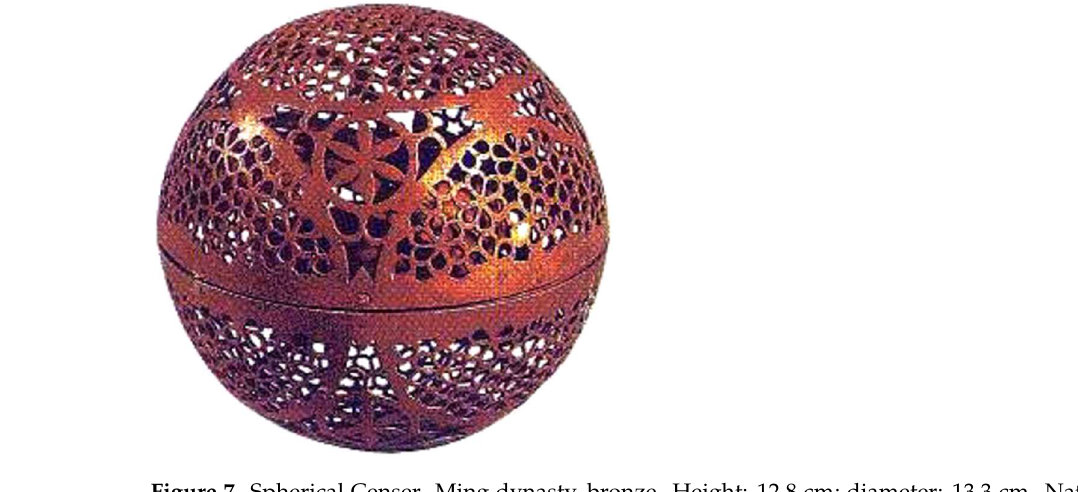
Figure 9. Left: Painting by Chen Hongshou 陳洪綬 depicting women using a xun long 熏籠 (per- fume basket), damask silk, 129.6 × 47.3 cm. Shanghai Museum. Right: Detail of the painting.